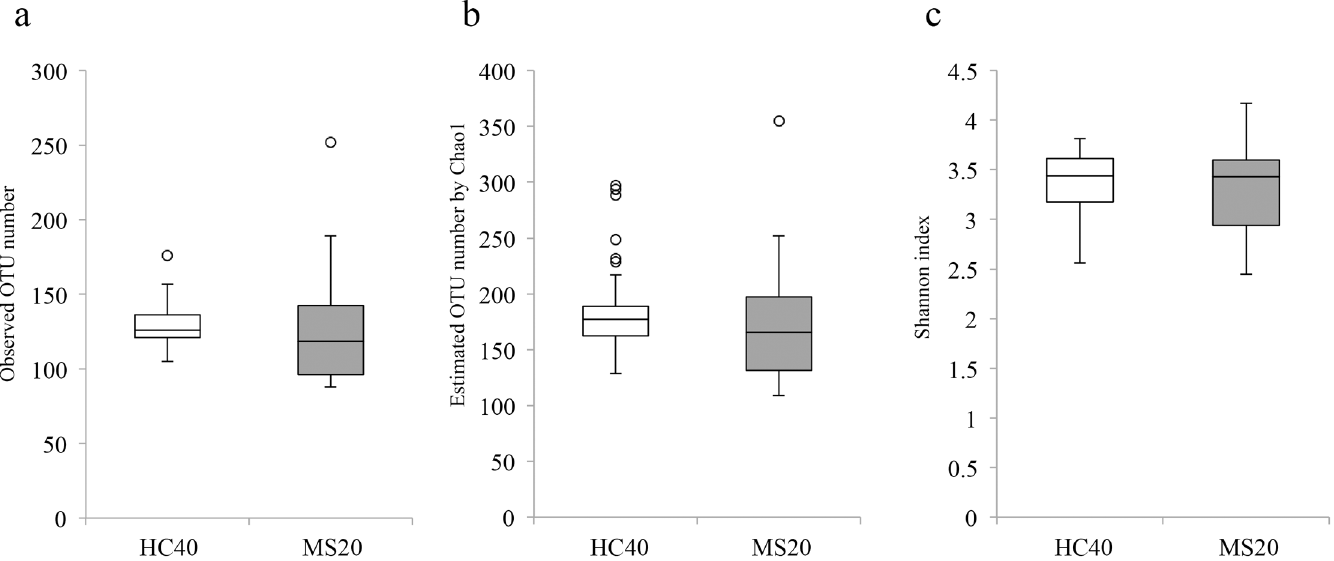
Fig 1. OTU/species diversity and richness in gut microbiota of HC40 and MS20 subjects. (a) Number of operational taxonomic units (OTUs) generated by clustering of 3,000 16S reads of gut microbiota samples from 40 healthy control subjects (HC40) and 20 patients with multiple sclerosis (MS20). (b) Estimated OTU numbers obtained from Chao1 extrapolation of the observed OTU numbers shown in (a). (c) Shannon index calculated from the observed OTU numbers. The vertical axes indicate the numbers of OTUs (a, b) and the Shannon index (c). Each box plot represents median, interquartile range, minimum, and maximum